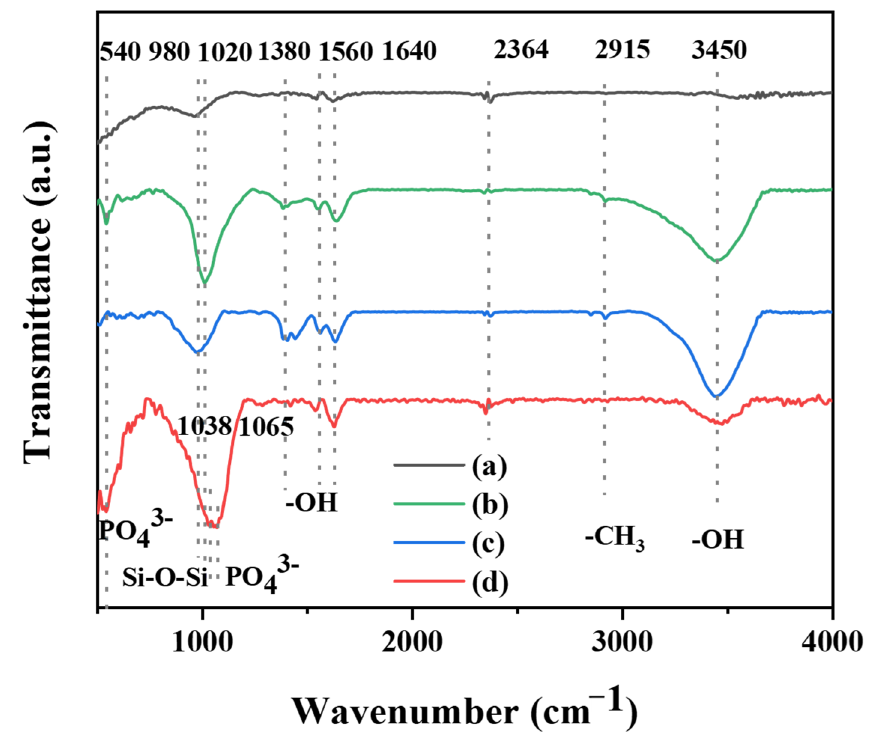
Figure 2. FTIR curves of ( a ) the original FeSiBCr powders, and the powders treated by ( b ) H 3 PO 4 - ethanol solution, ( c ) sodium silicate-aqueous solution, and ( d ) H 3 PO 4 -ethanol solution followed by sodium silicate-aqueous solution.